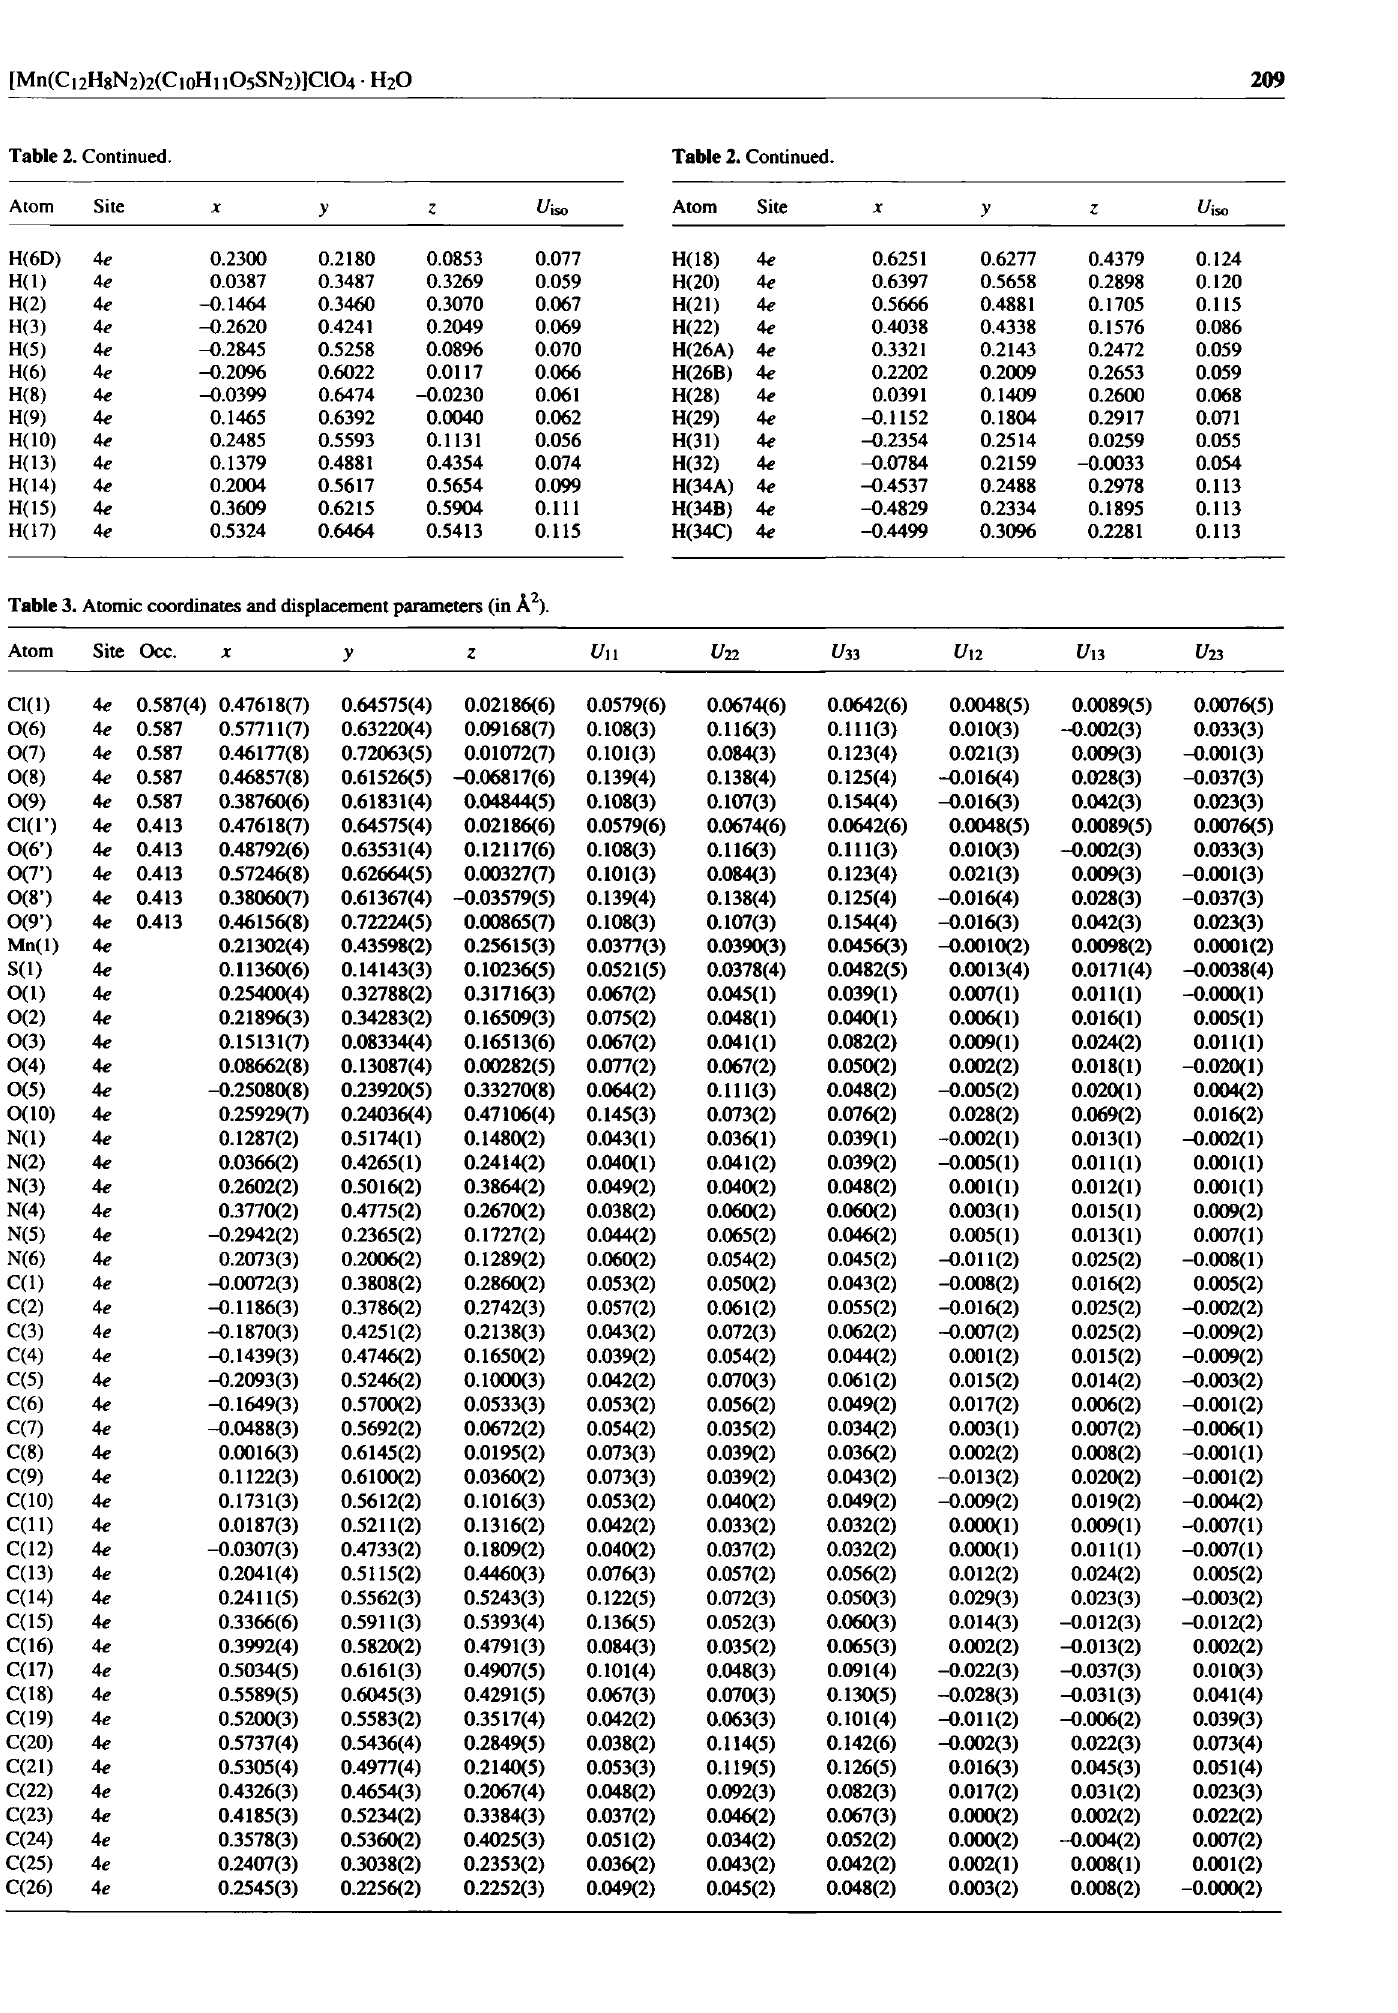
Table 3. Atomic coordinates and displacement parameters (in Ä 2